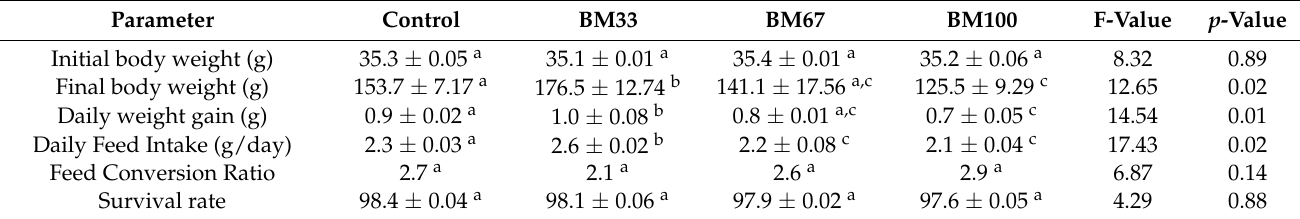
Table 4. Mean ( ± SE) growth parameters of growing Nile tilapia fish fed on the experimental diets.